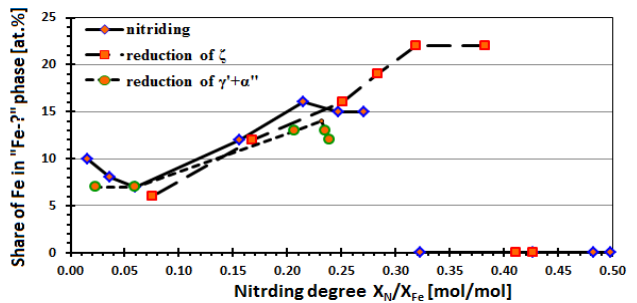
Figure 3. The dependence of the share of iron in the amorphous phase “Fe-?” in samples (by the MS method) on their nitriding degree. Table 1. The Mössbauer parameters for selected spectra representative of the identified iron phases: